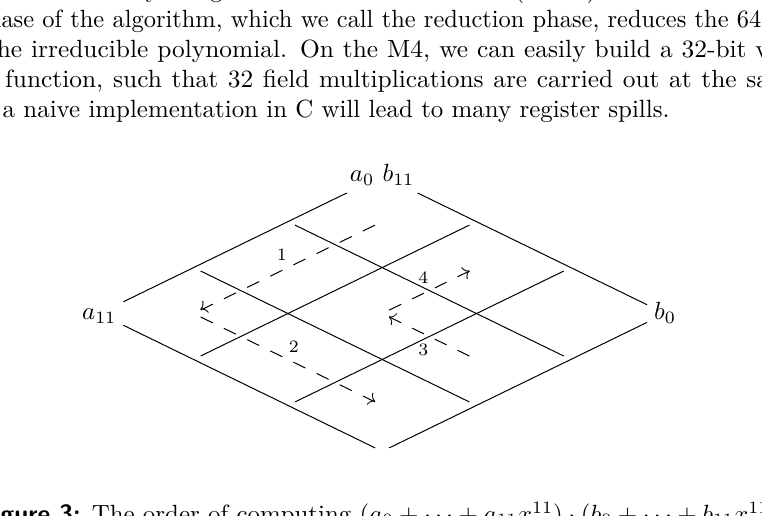
Figure 3: The order of computing ( a 0 + · · · + a 11 x 11 ) · ( b 0 + · · · + b 11 x 11